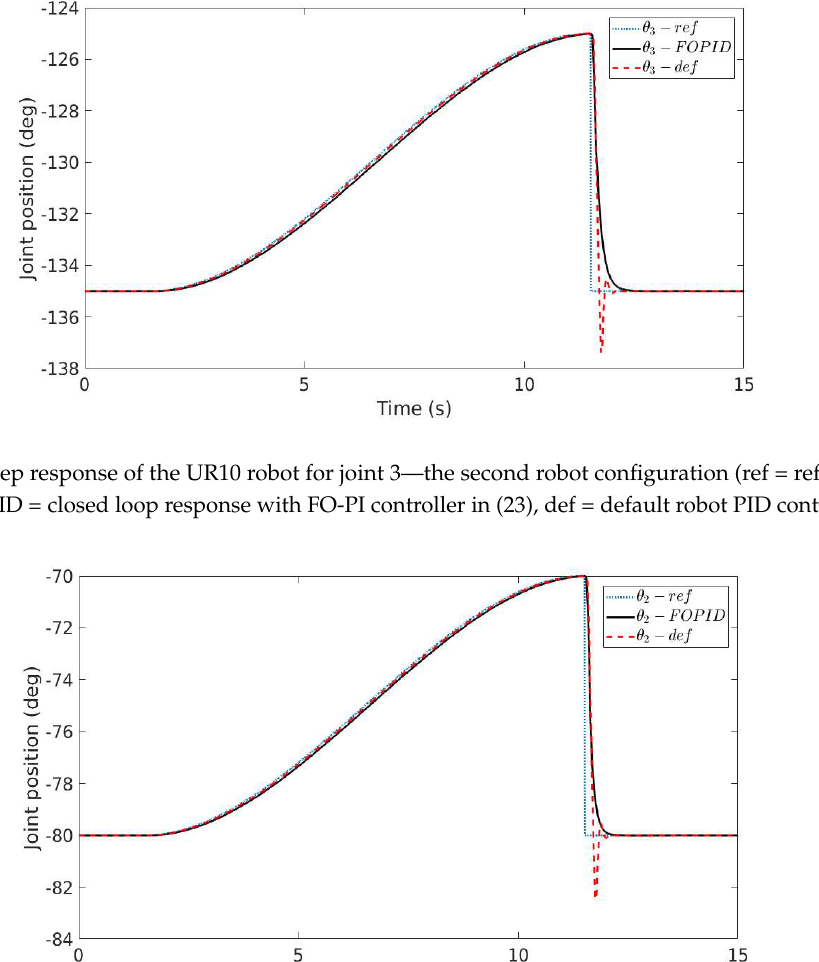
Figure 6. Step response of the UR10 robot for joint 2—the first robot configuration (ref = reference signal, FOPID = closed loop response with FO-PI controller in (23), def = default robot PID controller).